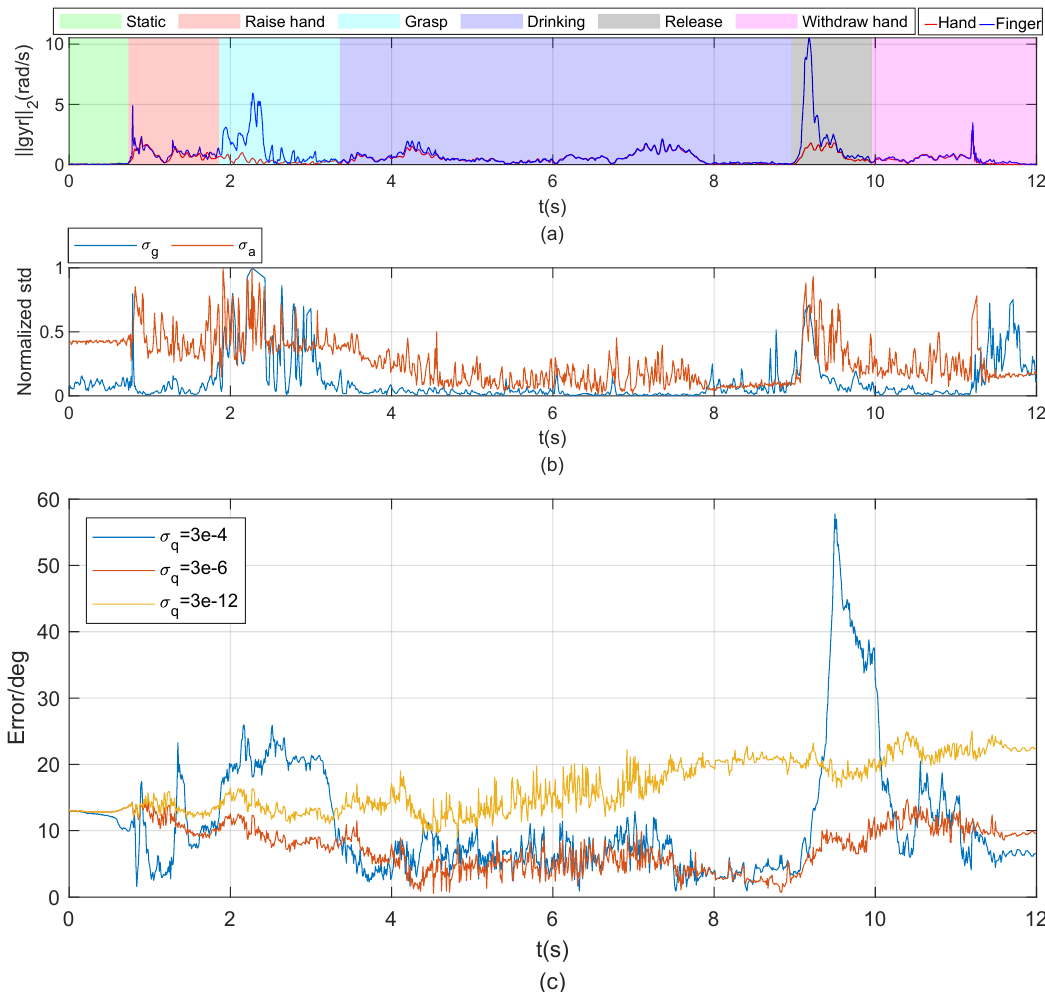
Figure A2. Relative orientation between the hand and thumb during the water-drinking process. Subfigure ( a ) shows the output norms of the two gyroscopes (on the hand and finger tip respectively). Subfigure ( b ) shows the normalized SDs σ a and σ g from Equation (18) and (21). Larger σ a and σ g mean larger measurement error. The EKF trusts the process model more and the measurement model less when σ a and σ g are larger. Subfigure ( c ) shows the estimated results with different SDs of the process model. The variance of process error Q was determined as σ p I 4